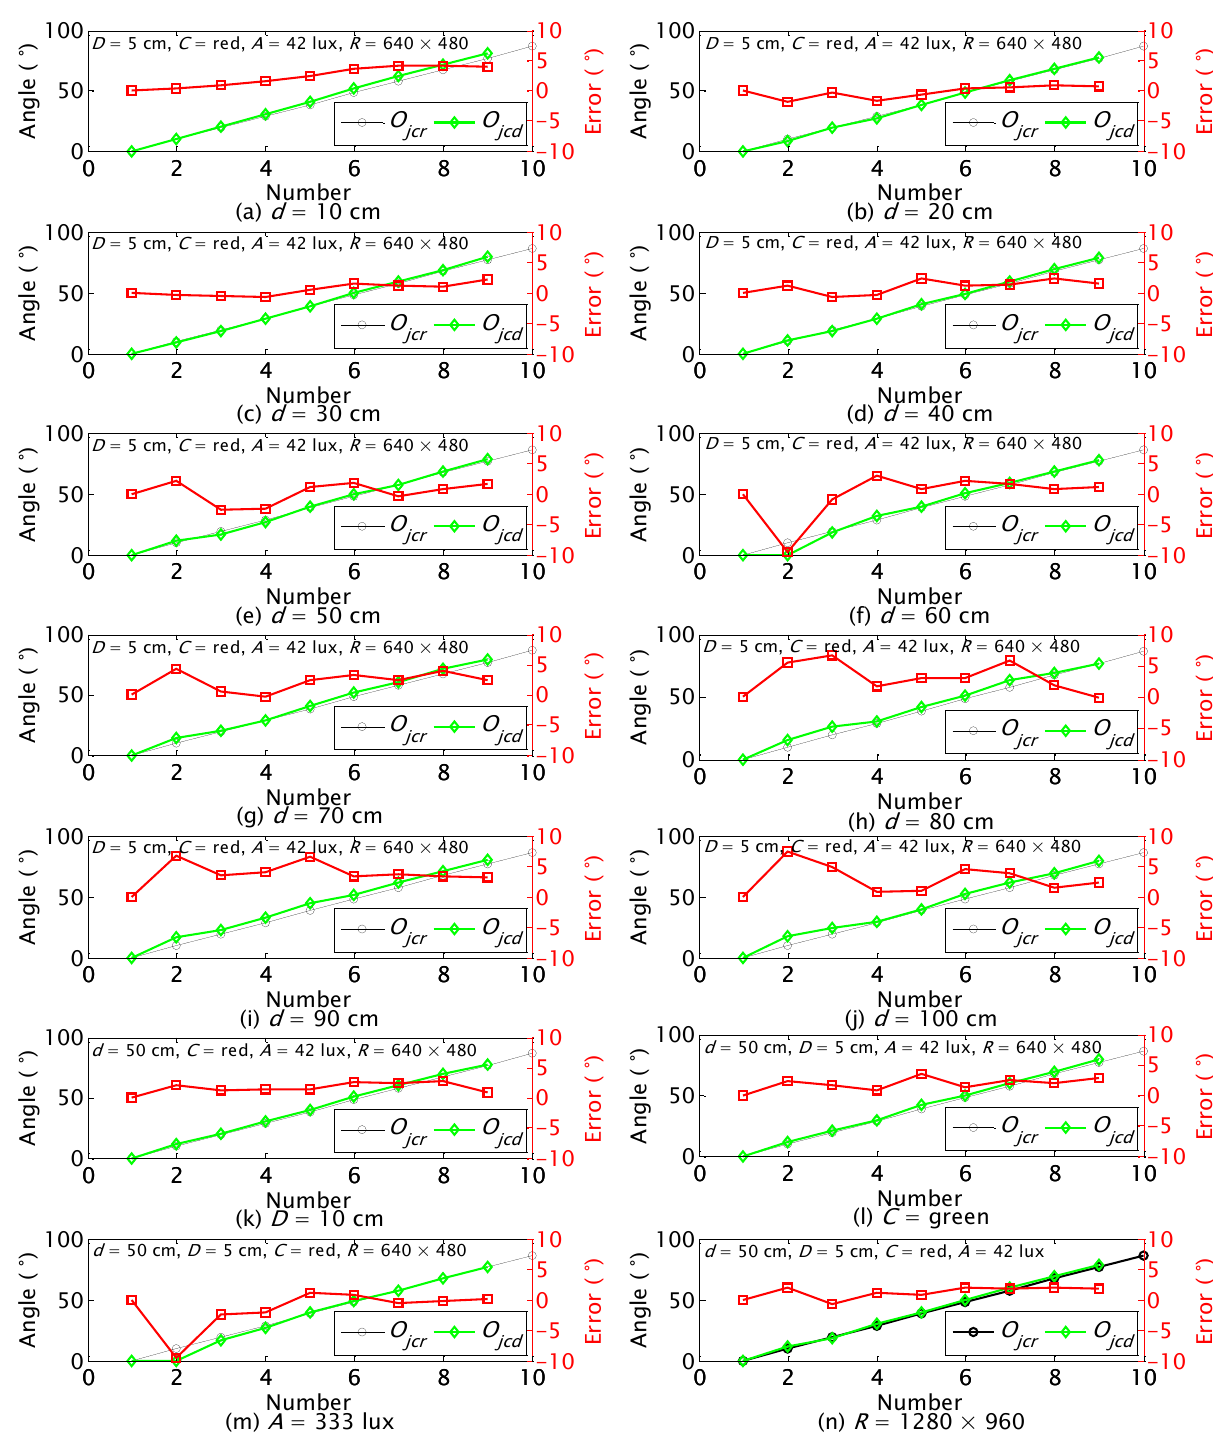
Figure 15. O jc detection results at different distances d , diameters of the label D , and colors of the label C , ambient illuminations A and resolutions of the color camera R